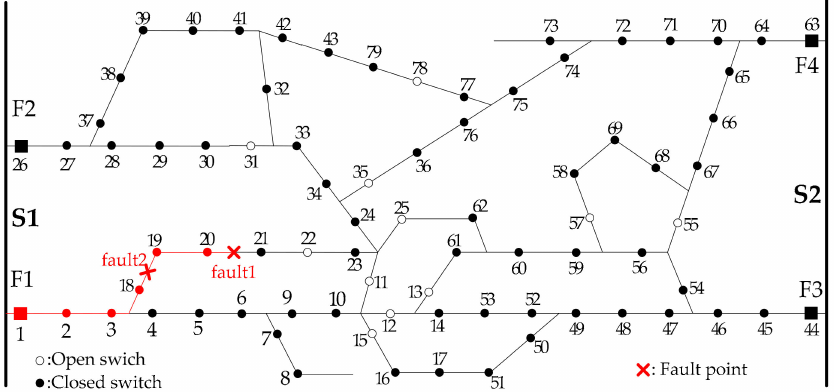
Figure 15. Simultaneous faults in the same